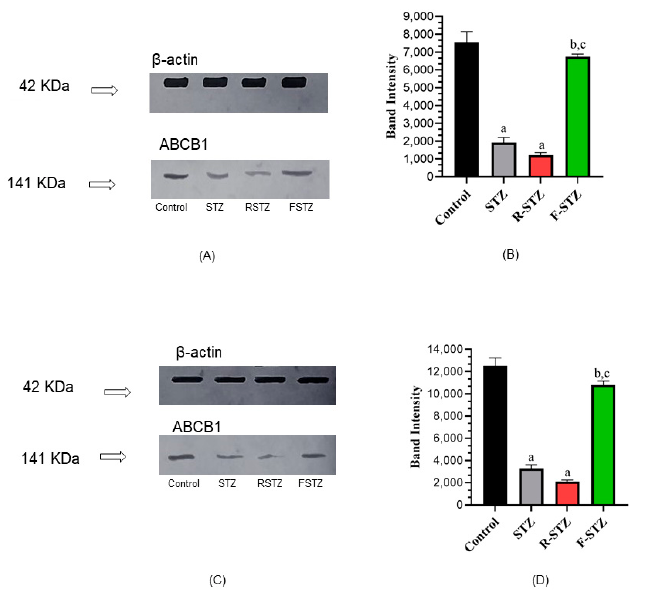
Figure 5. Cellular permeability-glycoprotein; ABCB1 level in pancreatic and renal tissue samples of the study groups ( A ) Pancreatic representative WB; ( B ) Pancreatic densitometric quantification of WB, bars represent mean ± SD of band intensity ( n = 5); ( C ) Renal representative WB; ( D ) Renal densitometric quantification of WB, bars represent mean ± SD of band intensity ( n = 5). (a) Significant difference from normal control group at p < 0.05; (b) Significant difference from STZ group at p < 0.05; (c) Significant difference from R-STZ group at p < 0.05.